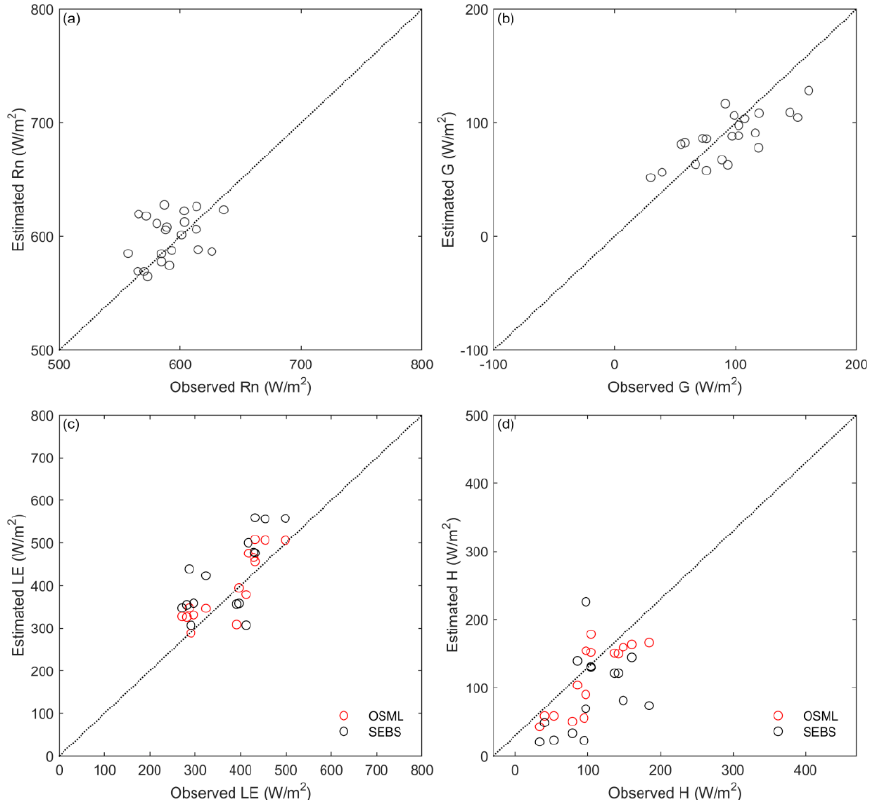
Table 2. Summary of validation statistics for validating estimated surface fluxes (W/m 2 ).